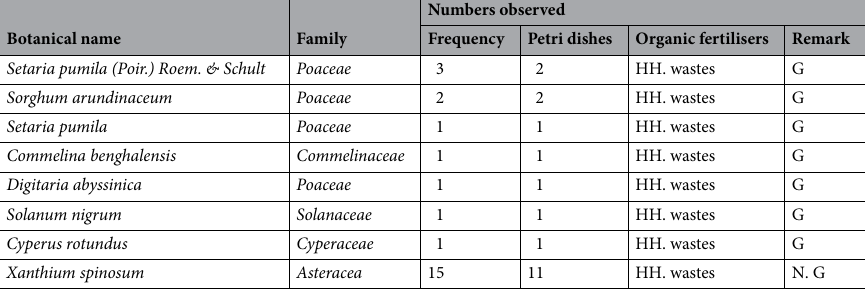
Table 1. Weed species and frequencies identified by the weed seed germination test. HH wastes, household wastes, G germinated, N.G . not germinated.